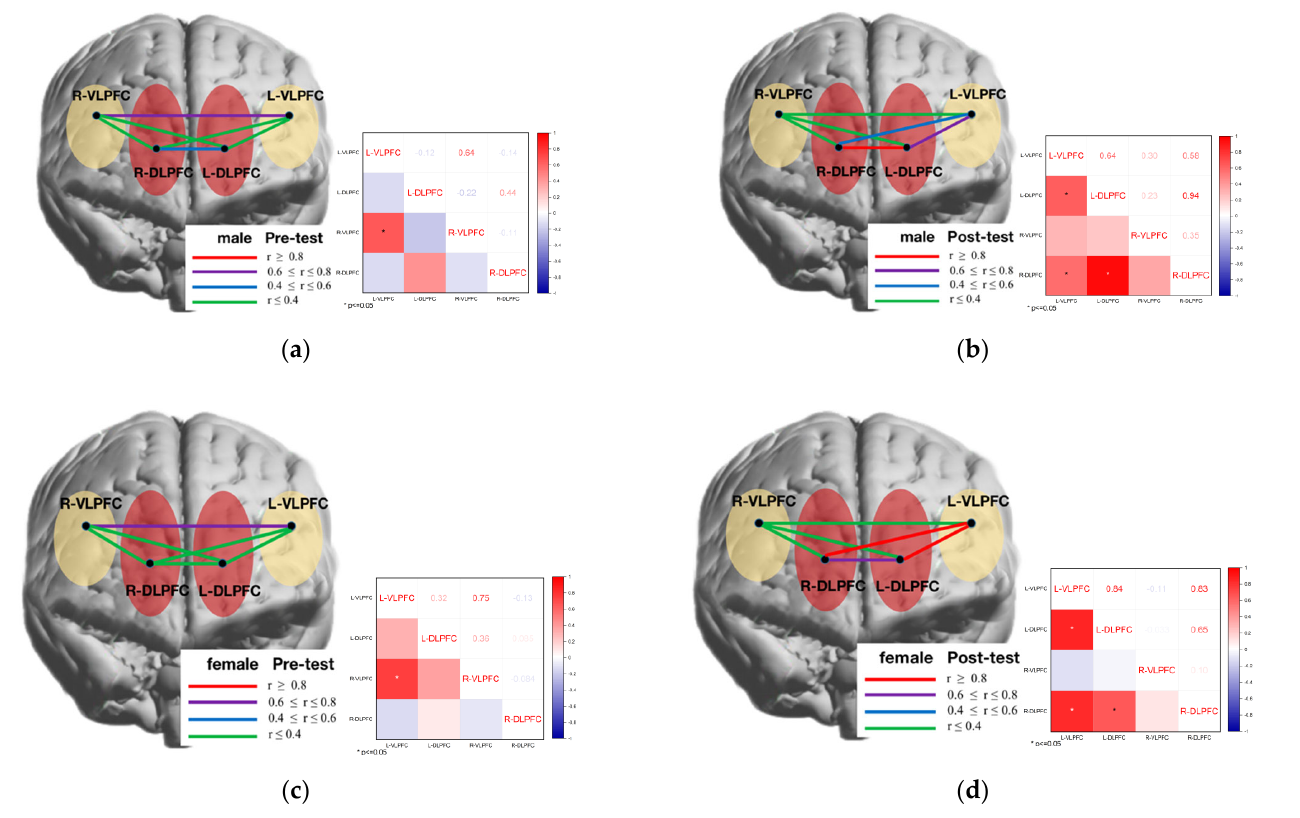
Figure 13. Correlation of functional connectivity of brain networks in different genders before and after directional exercise intervention in the experimental group. ( a ) male pre ‐ test; ( b ) male post ‐ test; ( c ) female pre ‐ test; ( d ) female post ‐ test.